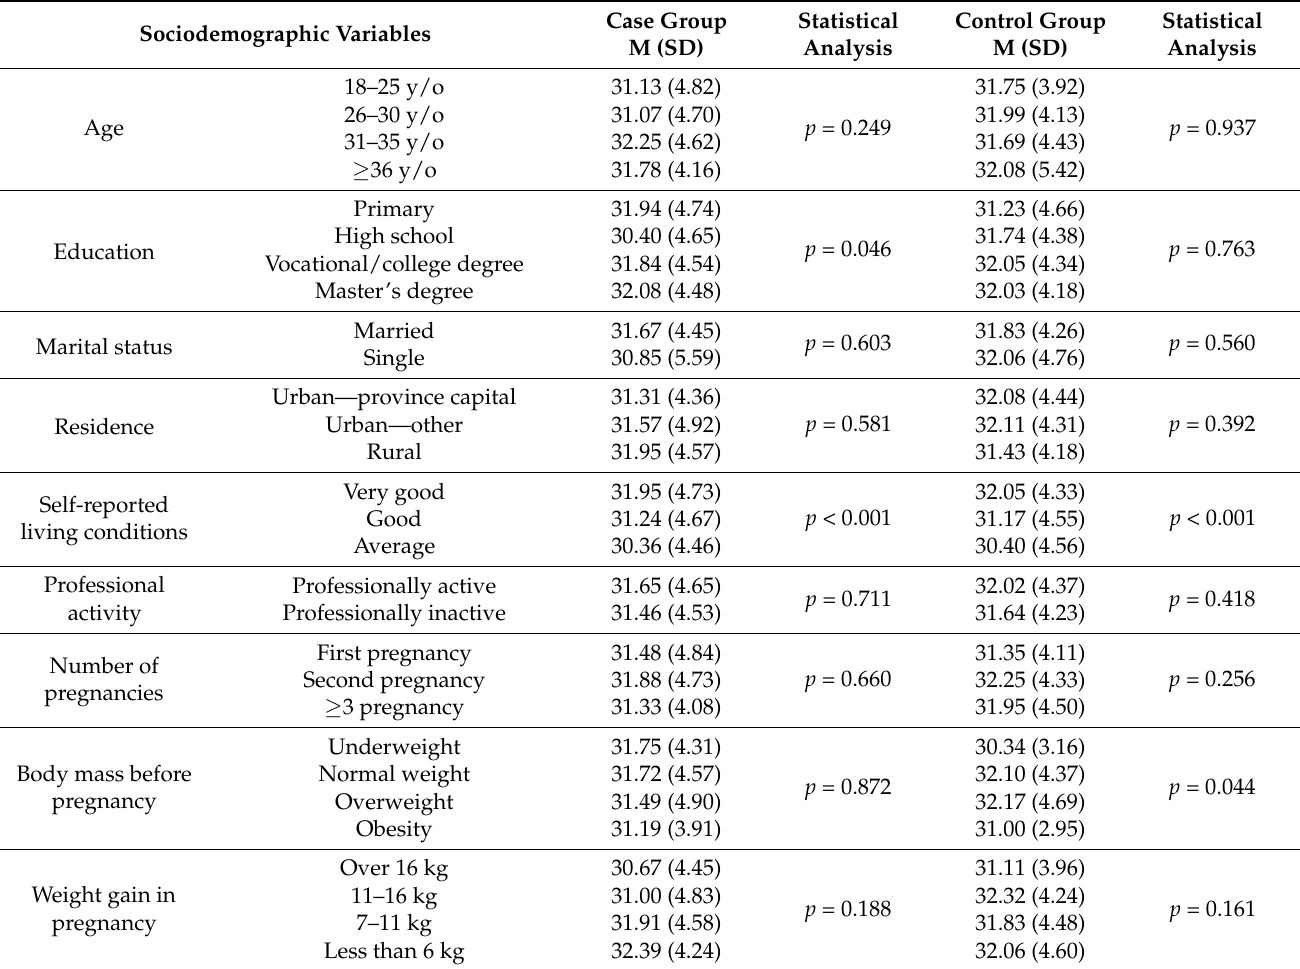
Table 5. The analysis of the relationship between the sense of self- efficacy and sociodemographic variables in pregnant